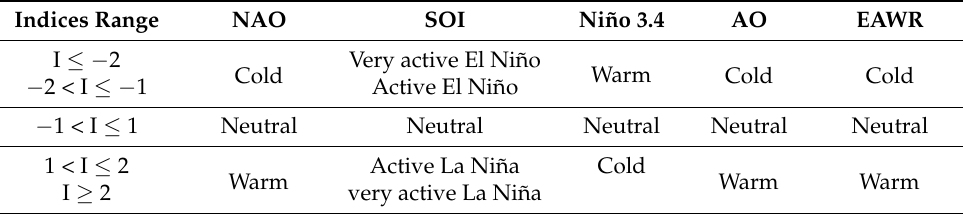
Table 2. The classification of NAO, SOI, Niño 3.4, AO, and EAWR indices. Indices Range NAO SOI Niño 3.4 AO EAWR I ≤ − 2 Very active El Niño Warm Cold Cold − Cold 2 < I ≤ − 1 Active El Niño Neutral Neutral Neutral Neutral